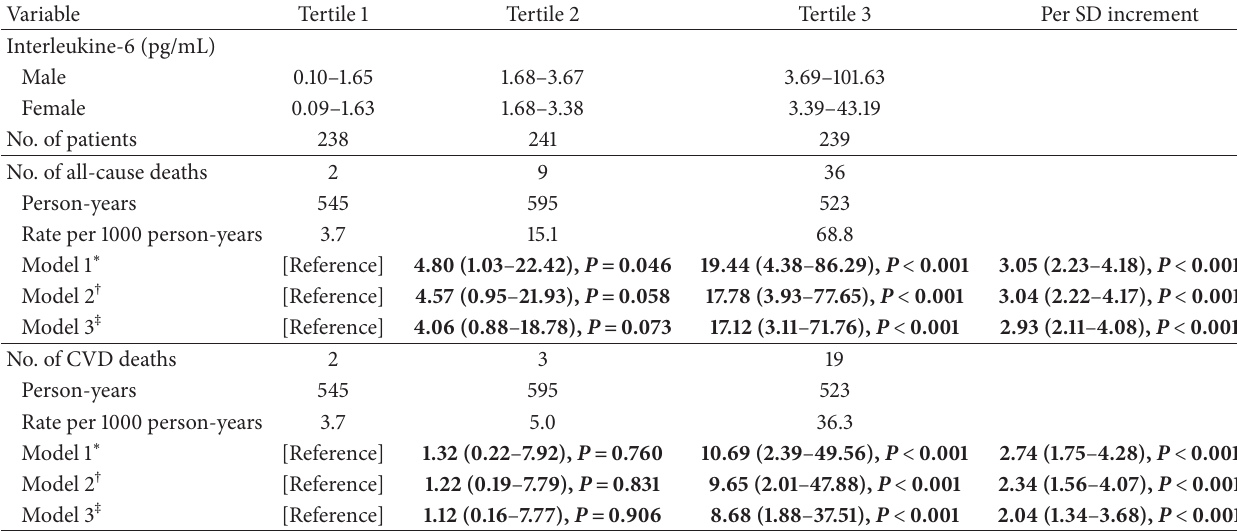
Table 2: Hazard ratios of all-cause and cardiovascular mortality stratified by interleukine-6 tertiles and continuous levels.